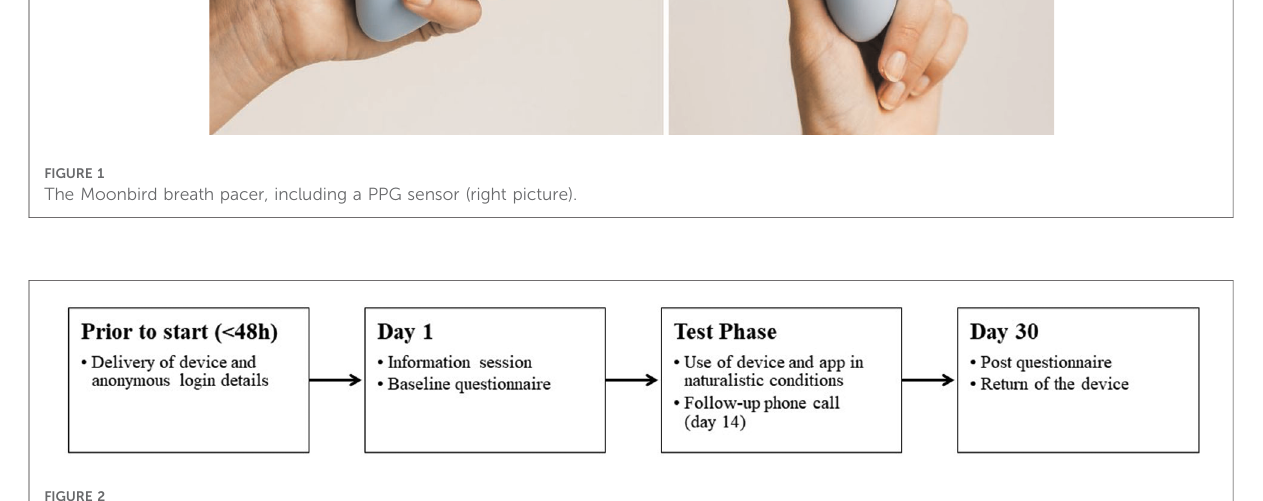
FIGURE 2 Visual representation of the procedure of the